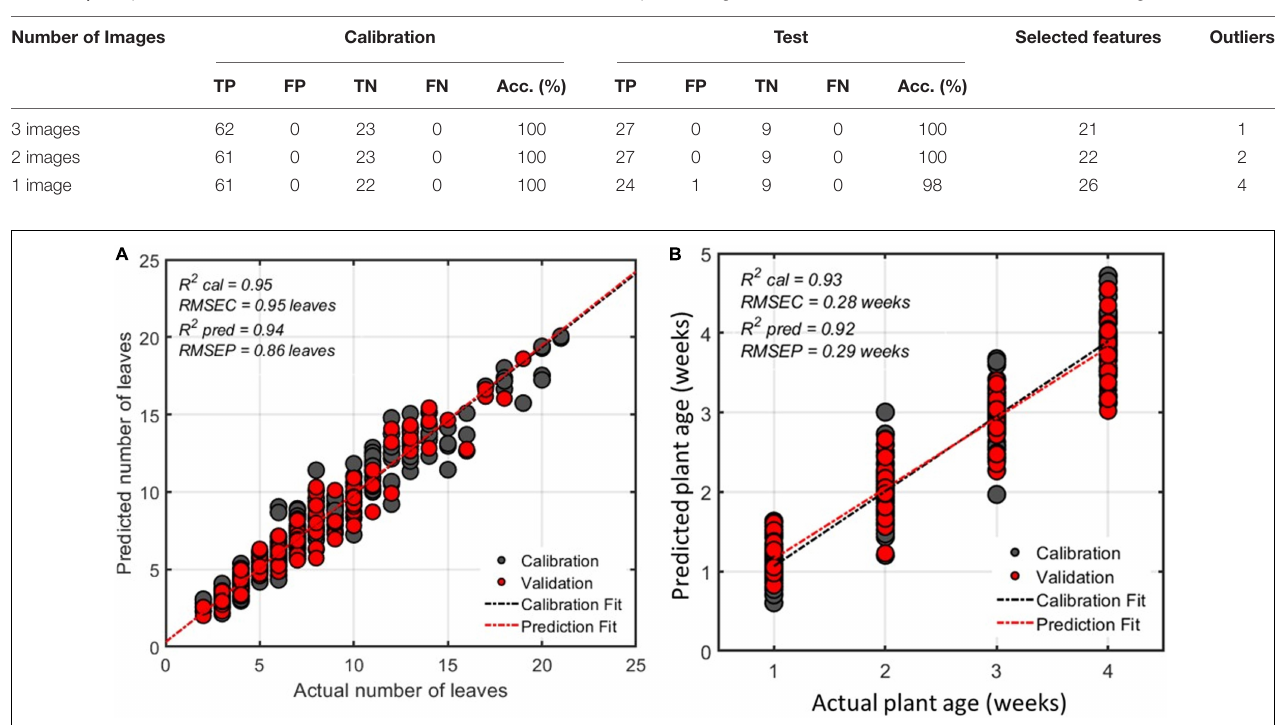
FIGURE 8 | Regression plot from model for estimating number of leaves of watermelon plant (A,B) watermelon plant age for all varieties estimated using 21 selected features.